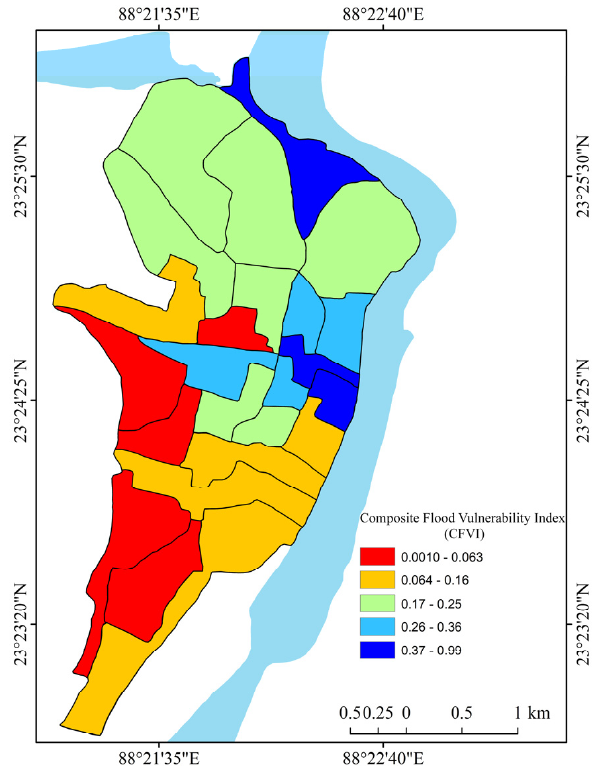
Figure 44. Composite flood vulnerability index of Nabadwip Municipality (2000).